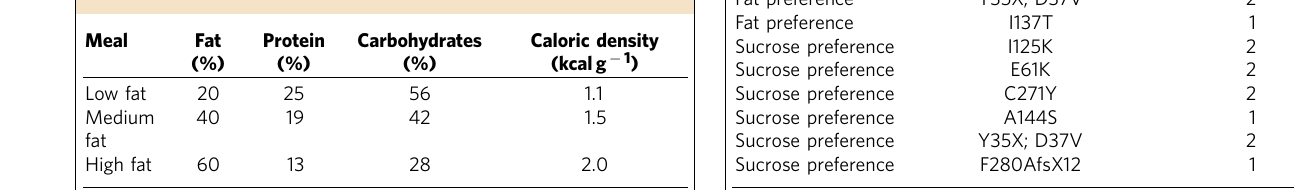
Table 1 | Macronutrient composition of meals used in the fat preference test.